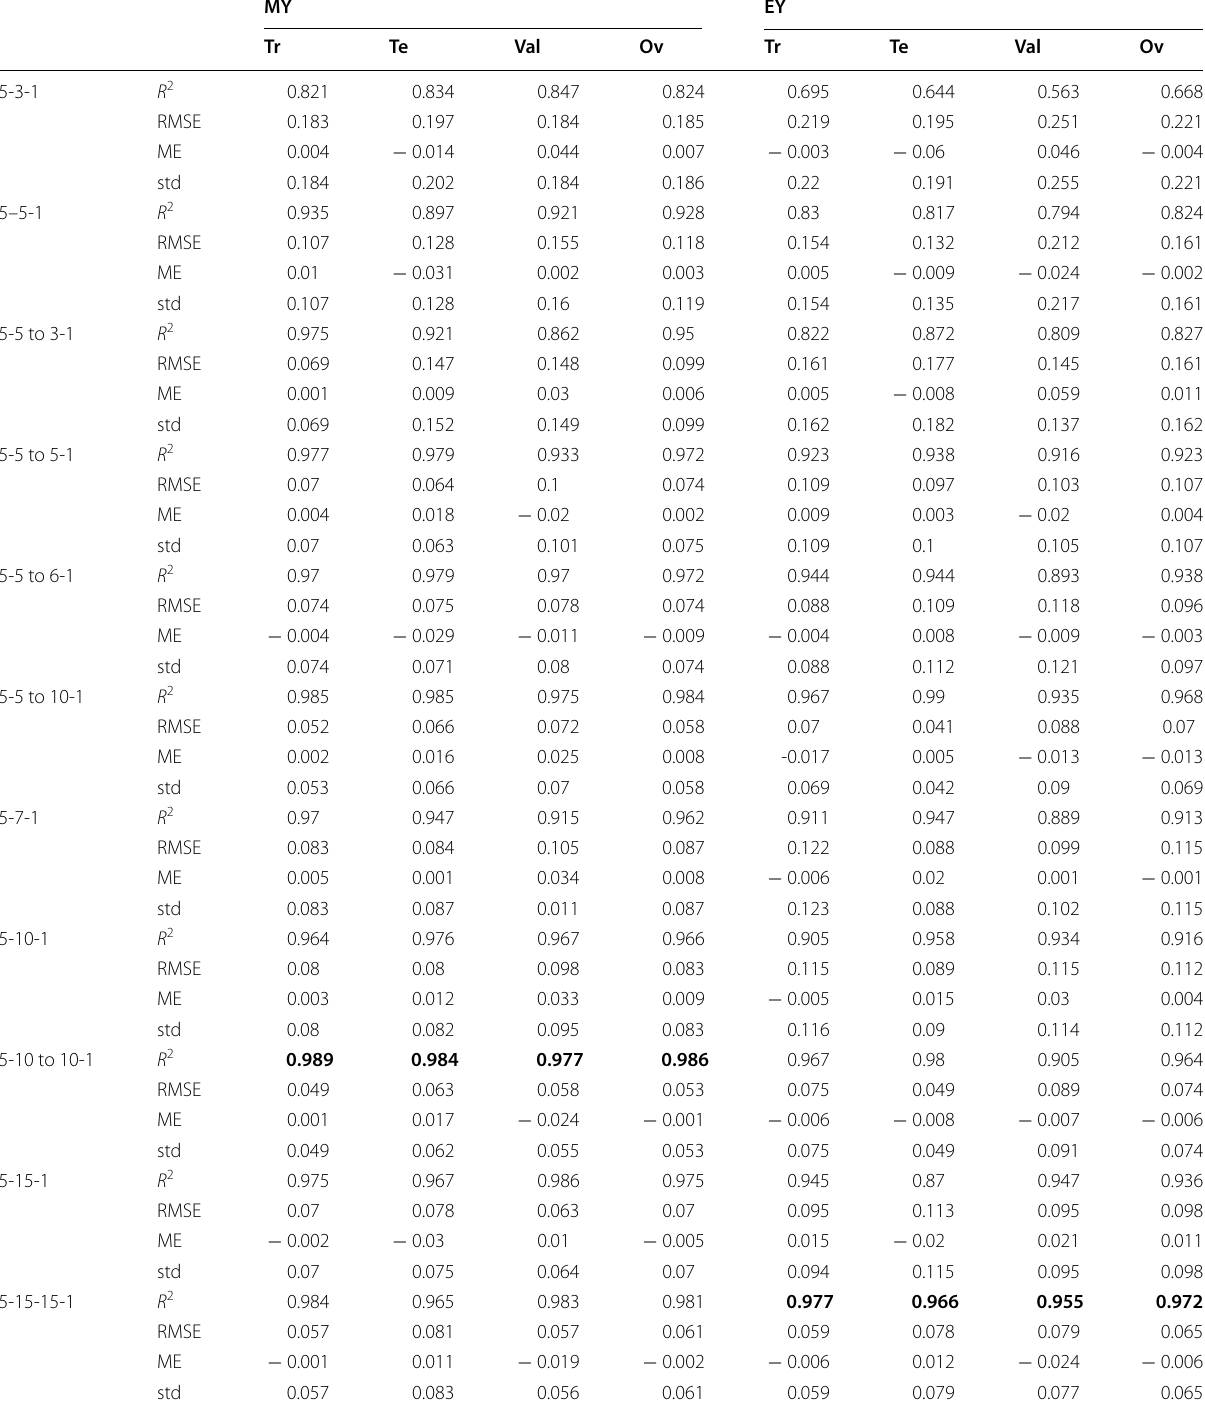
a Tr training, Te testing, Val validation, Ov